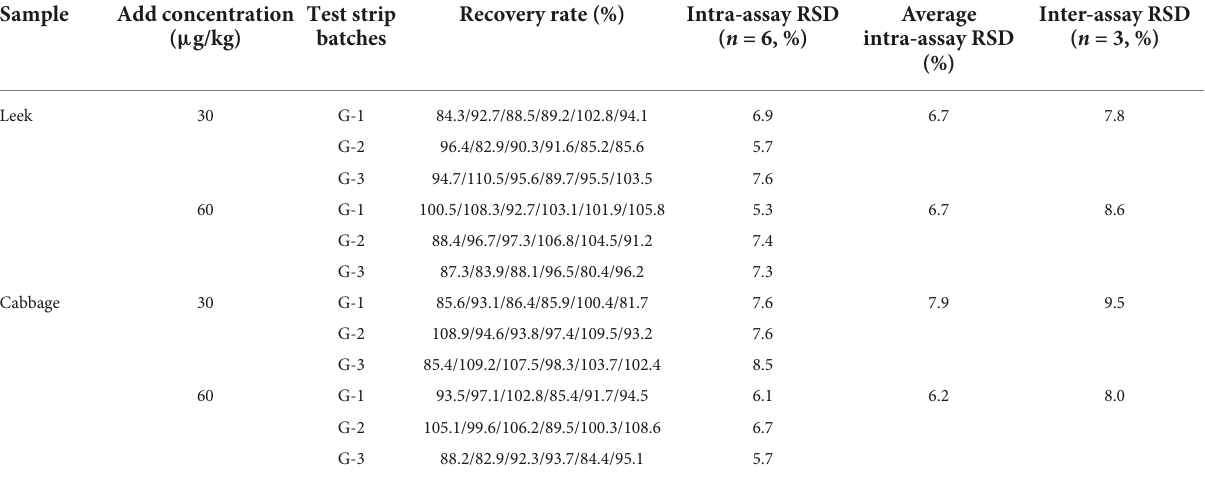
TABLE 4 Test strip accuracy and precision test